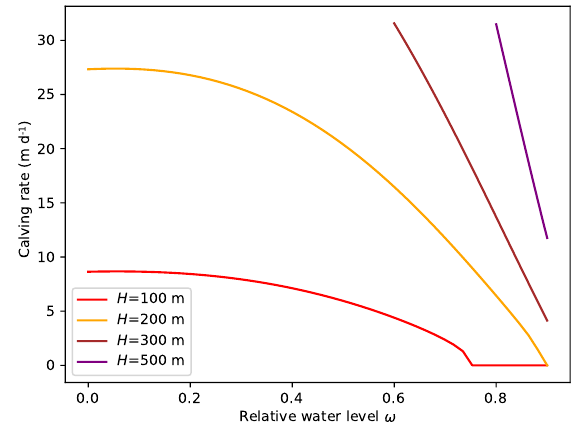
Figure 12. Calving rates predicted by the parametrization as a func- tion of relative water level. Calving rate decreases under increase of the relative water level ω for constant total ice thickness H .